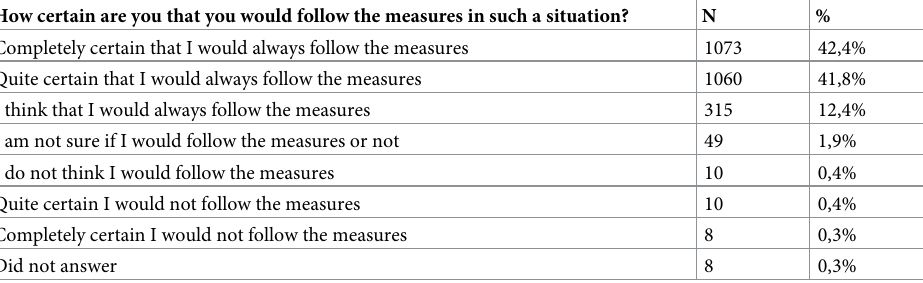
Table 1. Number of responses and percentage share for each response